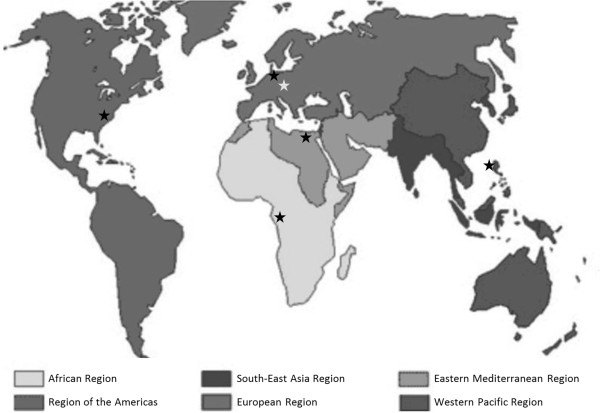
Location of WHO regions and headquarters [20].